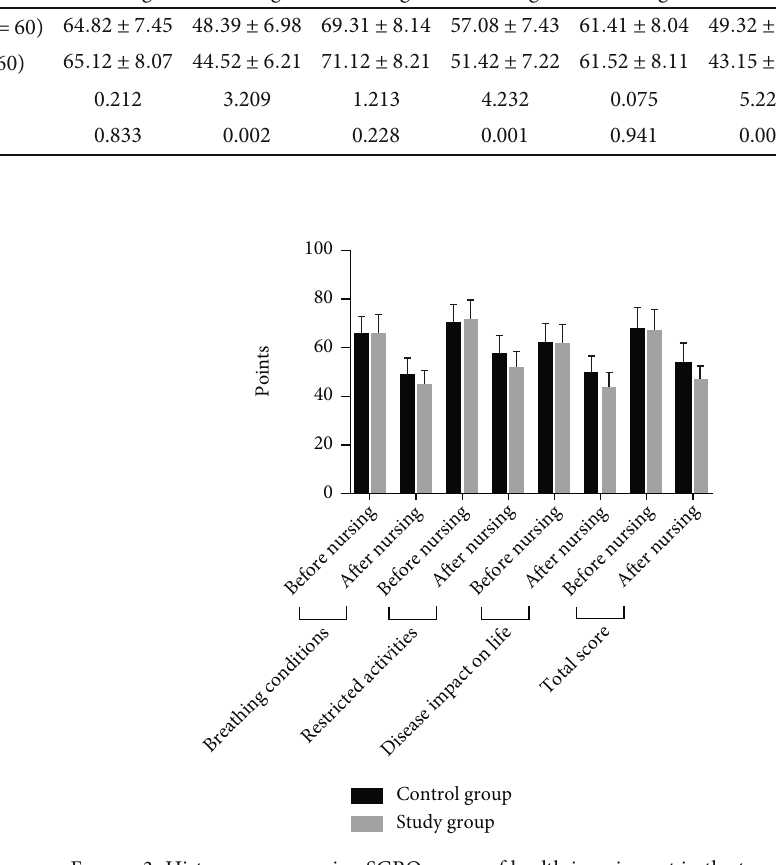
Figure 3: Histogram comparing SGRQ scores of health impairment in the two